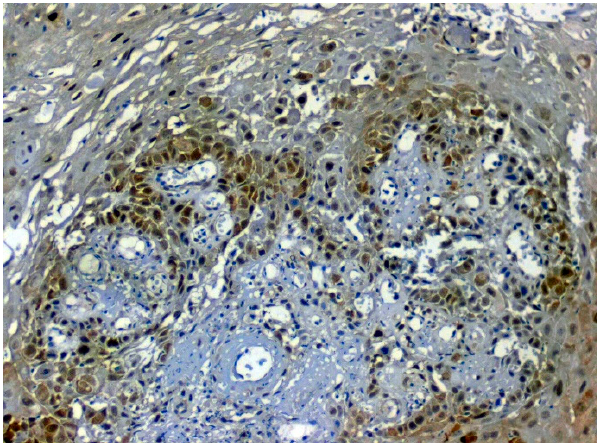
Figure 11. IHC for HSP 70 in OSMF samples (under 20 × magnification).